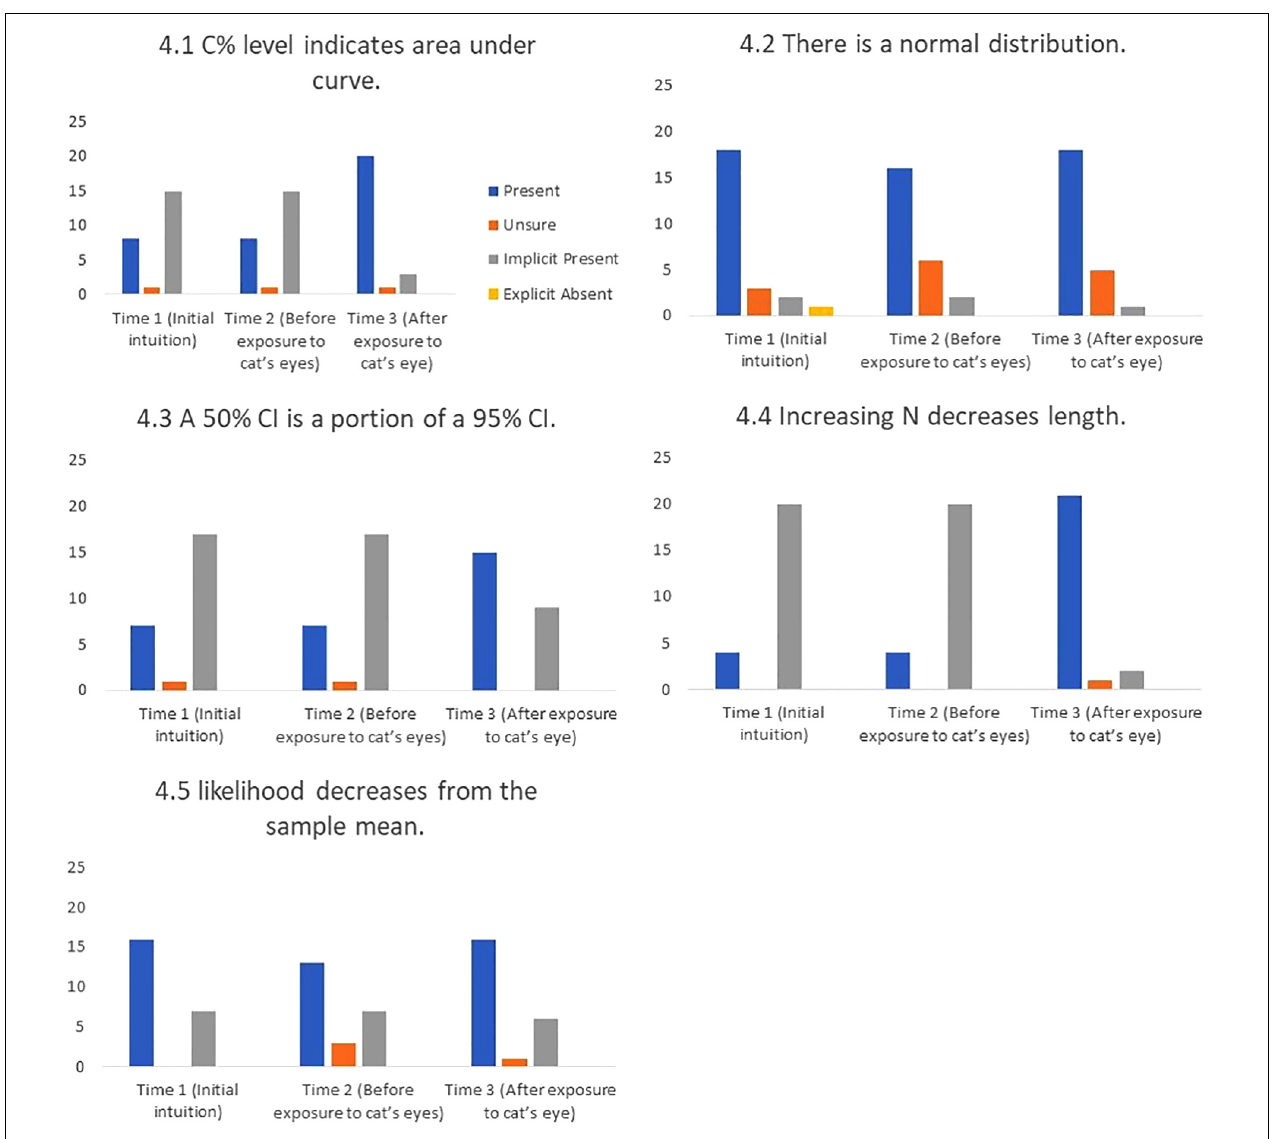
FIGURE 11 | Frequency of students stating intuitions at first mention (Time 1), at last mention immediately before exposure to cat’s eye program (Time 2), and after exposure to cat’s eye program (Time 3) for correct conceptions ( n =